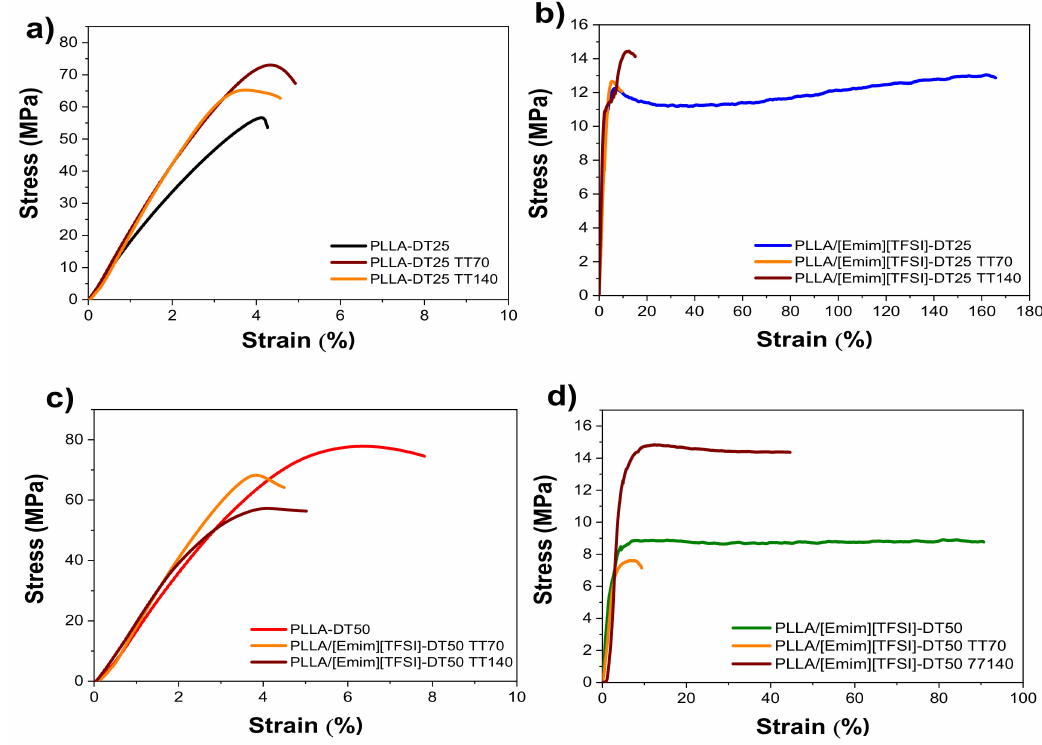
Figure 6. Stress vs. strain curves of PLLA and PLLA / [Emim][TFSI] films dried at 25 ◦ C ( a and b ) and 50 ◦ C ( c and d ), for samples subjected to post-thermal treatment at 70 and 140 ◦